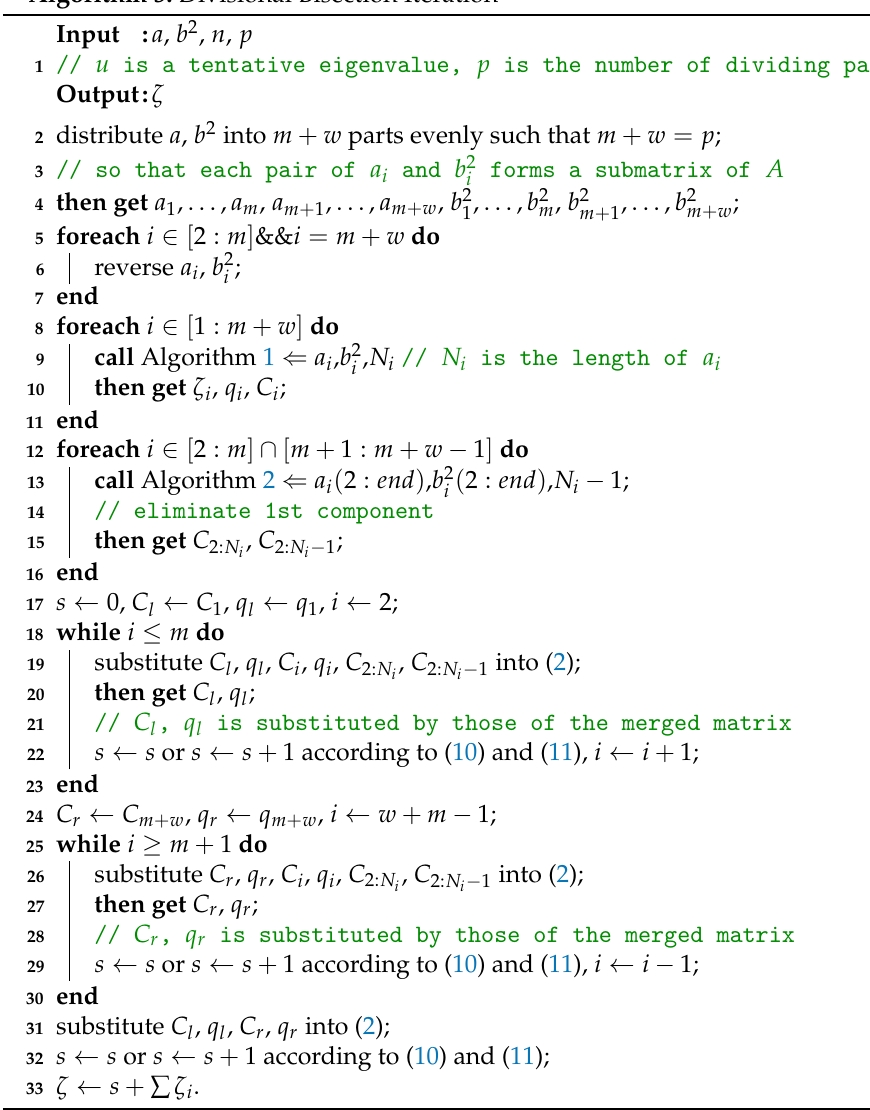
Algorithm 3: Divisional Bisection Iteration